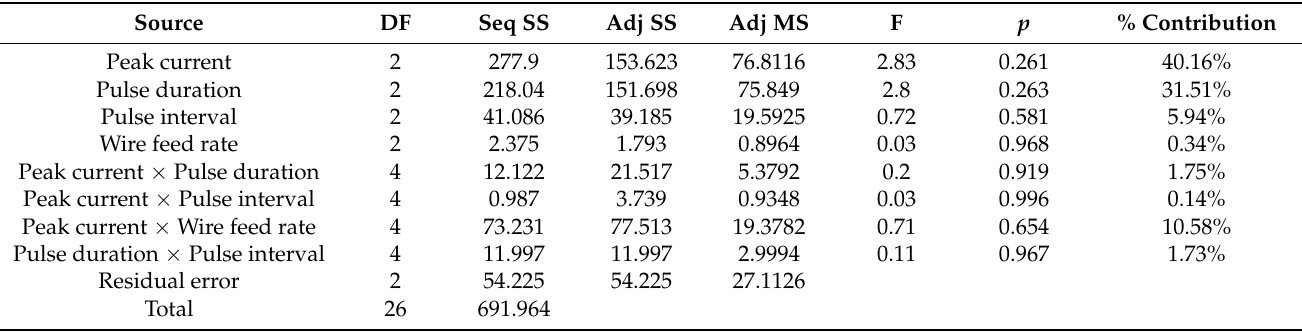
Table 7. ANOVA table for radial overcut.